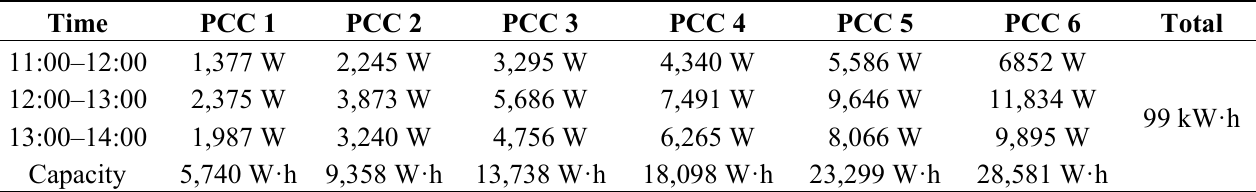
Table 4. ESSs charging schedule and capacity (case 3: most of the PVs are distributed on the lower side).